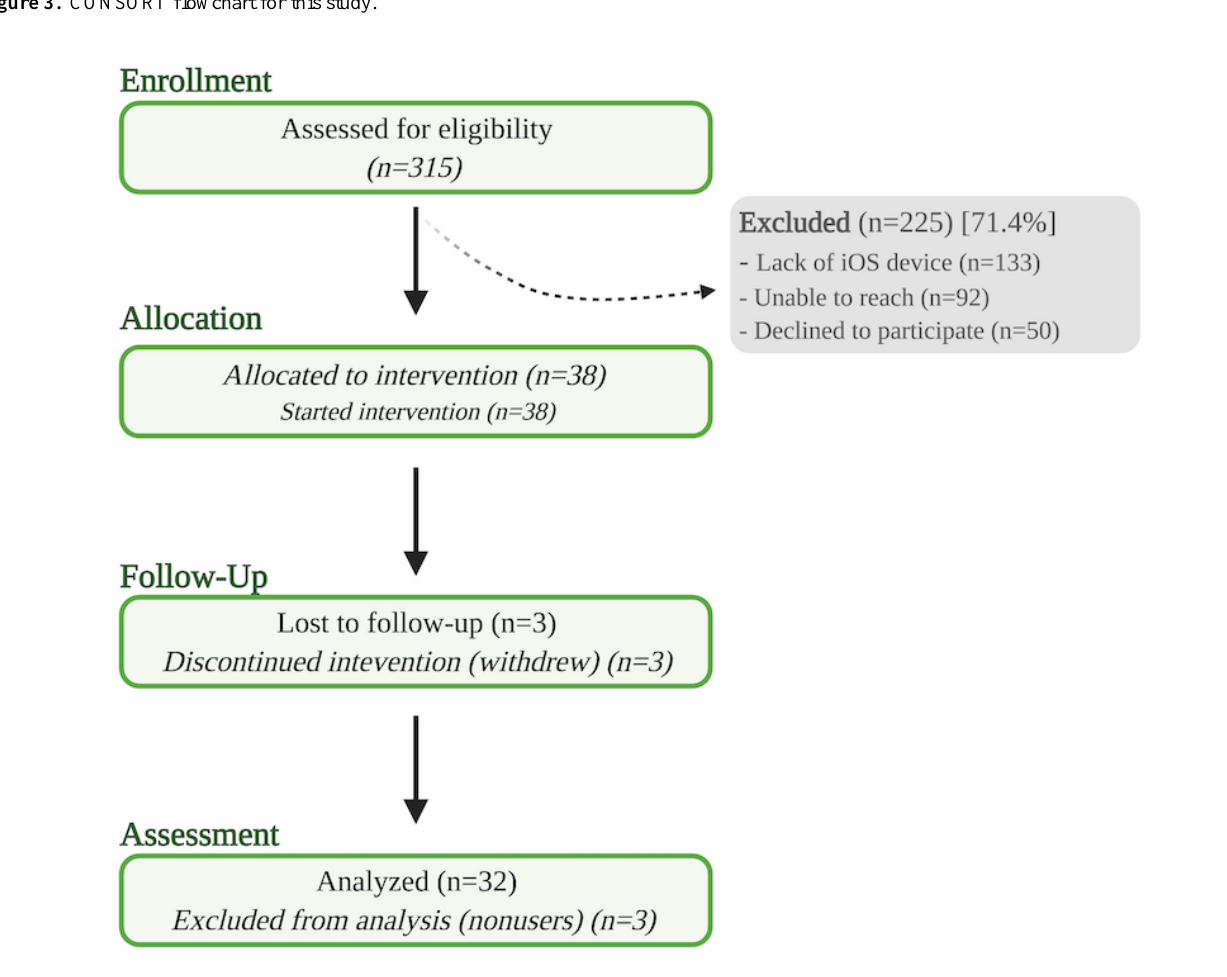
Figure 3. CONSORT flowchart for this